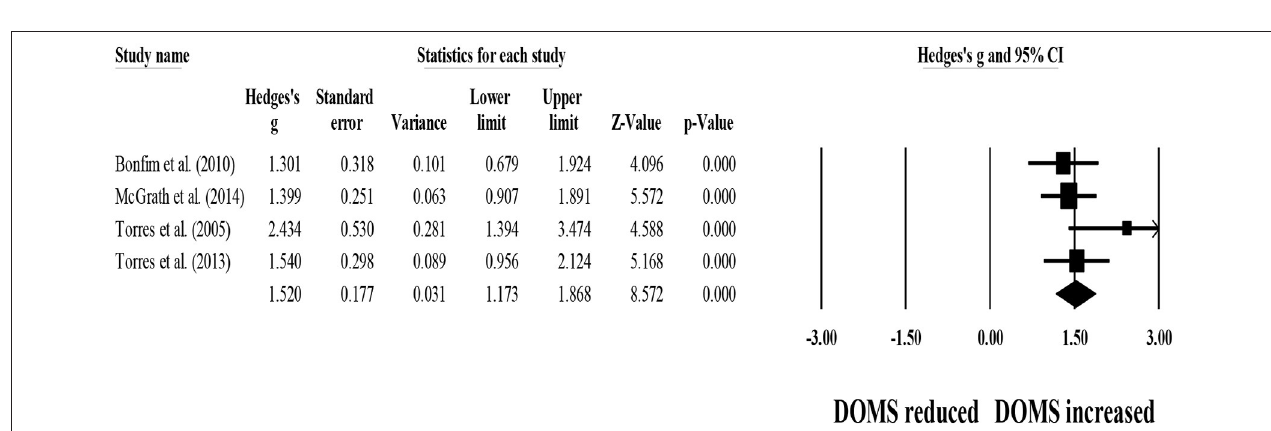
FIGURE 9 | Forest plot denoting 48-h post-exercise delayed onset of muscle soreness (DOMS) in participants that completed post-exercise stretching protocols. Values shown are effect sizes (Hedges’s g) with 95% confidence intervals (CI). The size of the plotted squares reflects the statistical weight of each study. The black diamond reflects the overall result. Note: positive values denote that post-exercise stretching protocols did not allow participants to recover their basal DOMS level (i.e., 0.00 in the figure).